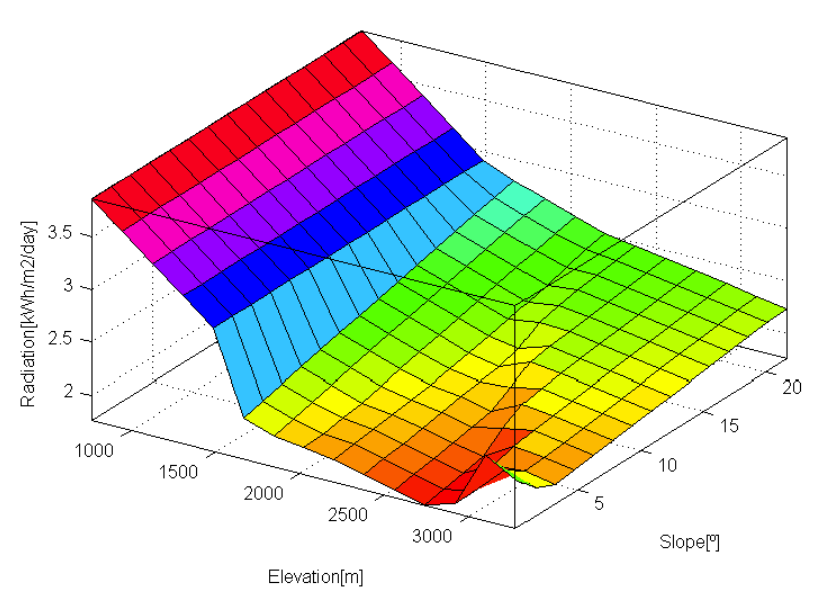
Figure 7. Fuzzy Inference System (FIS) Rule surface of elevation and slope for the estimation of